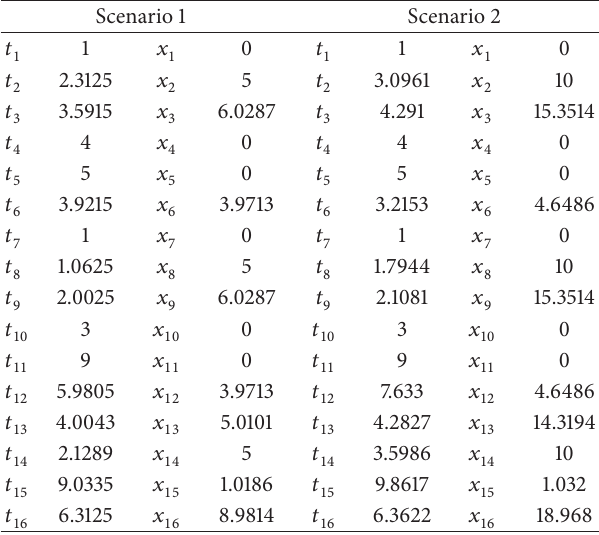
Table 7: The equilibrium link flows and travel times from solving 16-link